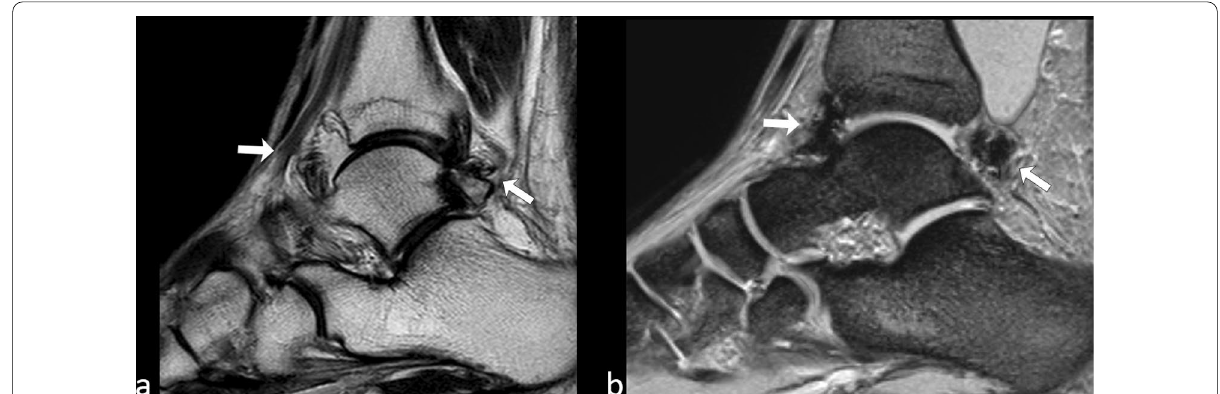
Fig. 9 Images of the right ankle ( a and b ) in a 35-year-old man with hemophilia. Presence of intra-articular hemosiderin (arrows) is seen with greater advantage on GE T2*-w. image ( b ) compared to TSE T2-w. scan ( a